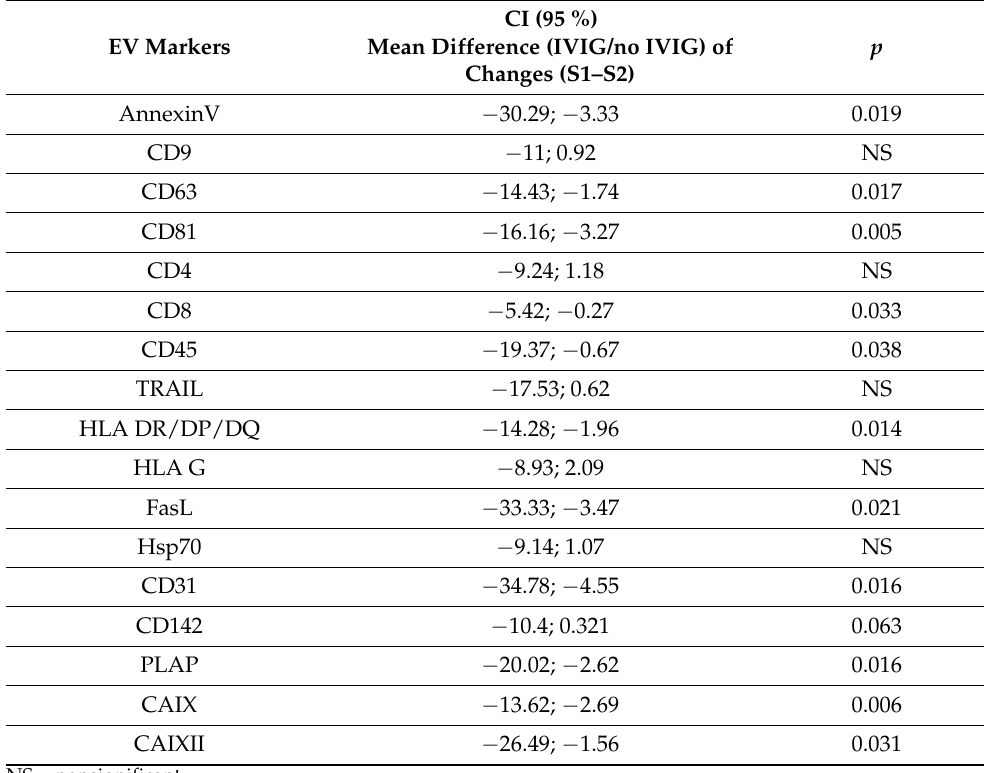
Table 4. Mean difference of IVIG in changes in progression of sEV levels measured at baseline (S1) to sixth gestational week